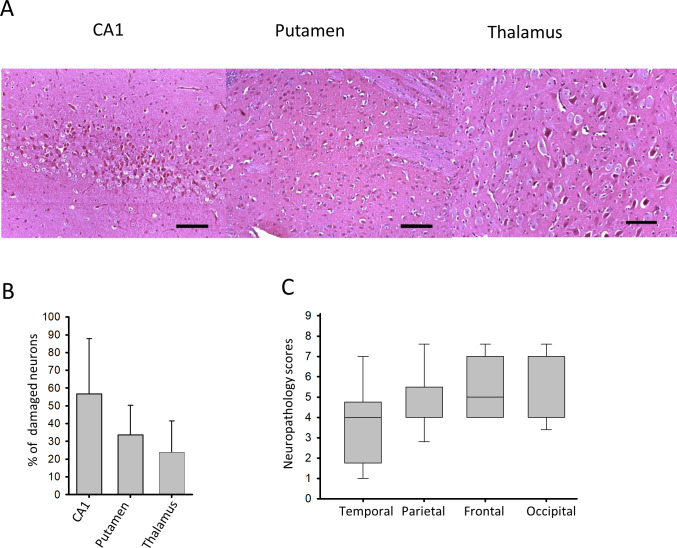
Neuronal injury evaluated at 24 hours after PA.(A) Representative photomicrographs showing injured red neurons at 24-hours of after asphyxia in the CA1 hippocampal region, the putamen, and the thalamus (scale bar: 100μm) (B) Cell counting revealed moderate neuronal damage in these regions (n = 8, mean±SEM). (C) Asphyxia also induced moderate/severe neocortical damage shown by medium/high neuropathology scores (lines, boxes, and whiskers represent the median, the 25th-75th, and the 5th-95th percentiles, respectively).